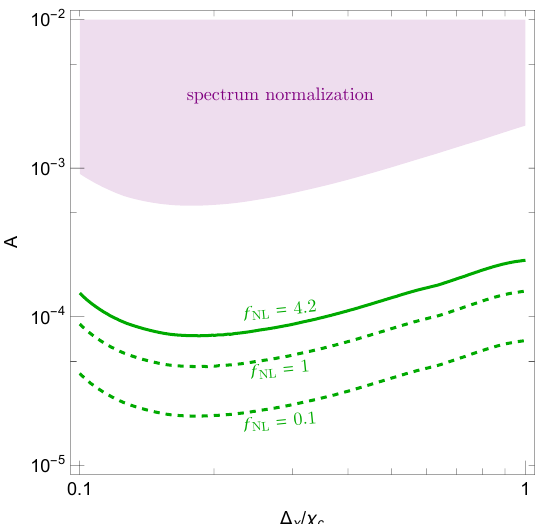
Figure 10 . Allowed region in the (∆ χ /χ c , A ) plane. The purple region is excluded by the spectrum normalization constraints in eq. (5.22). The green dashed lines show the predicted f NL based on eq. (5.27). The green solid line corresponds to the current 1 σ upper bound on local non- Gaussianity [41], above which the parameter space is excluded. We fix ‘/L = 10 − 14 , log( k (0) 20, and log( k (0) L ) = 10 . The results will not be affected much by other choices of these 1